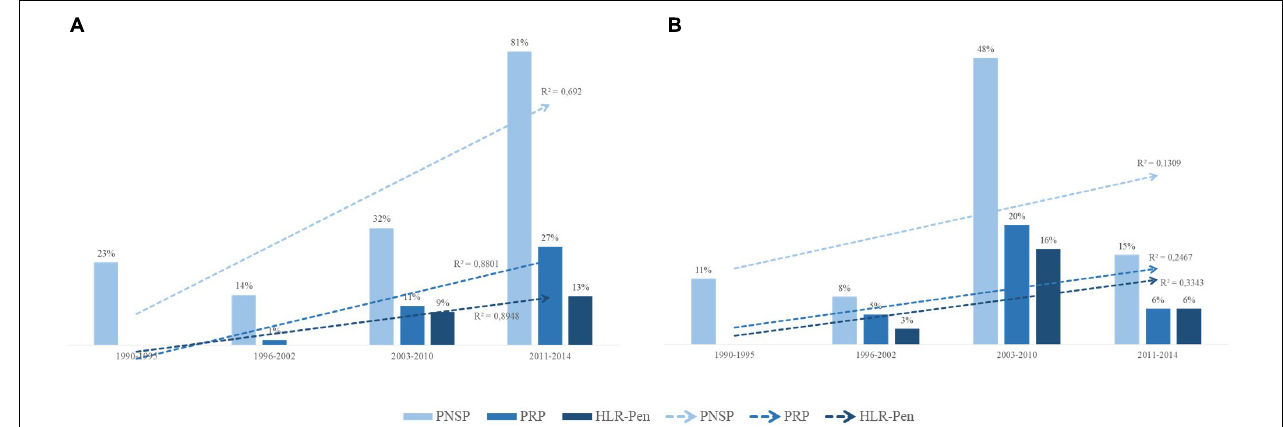
FIGURE 3 | Distribution over time of pneumococci with reduced susceptibility to penicillin (PRSP), penicillin-resistant pneumococci (PRP), and high-level penicillin resistant pneumococci (HLPRP). (A) Distribution among 355 S. pneumoniae isolates recovered from asymptomatic carriers. (B) Distribution among 428 S. pneumoniae isolates recovered from patients with IPD. Isolates showing penicillin MICs ≥ 0.12 < 2 µ g/ml were classified as PRSP, those with MICs ≥ 2 < 4 µ g/ml were classified as PRP and those with MIC ≥ 4 µ g/ml were classified as HLPRP.